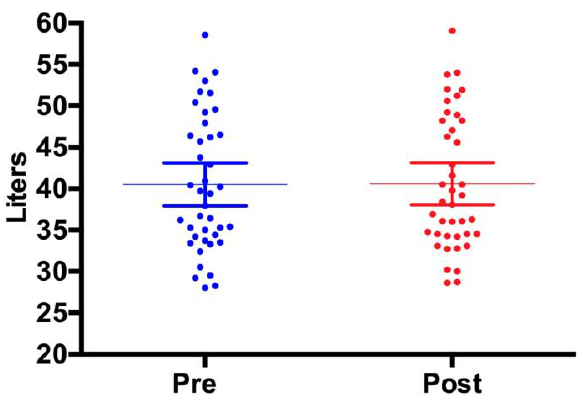
Figure 4. Total Body Water. The InBody BIA device was used to assess total body water. There were no changes pre versus post for total body water. The data is presented as the mean (middle horizontal line) with a 95% confidence interval (CI). Pre: Lower 95% CI of mean 37.91, Upper 95% CI of mean 43.12. Post: Lower CI of mean 38.05, Upper CI of mean 43.15.